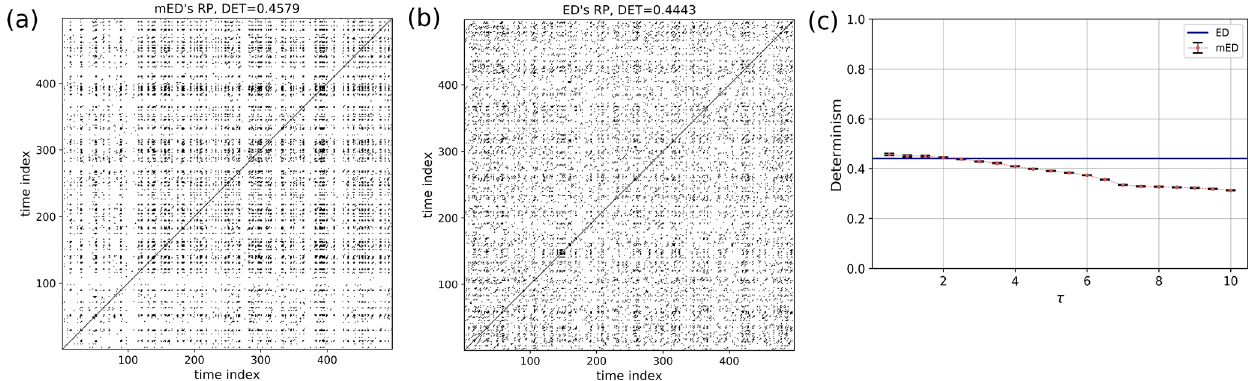
Figure 7. Generated time series from a (a) homogeneous Poisson process (total length = 10000), (b) repeating Poisson process (total length = 22442), and (c) Poisson process with periodical forcing to mimic discharge time series (total length 0–500 with 10000 equally spaced points); small red bars indicate the events.